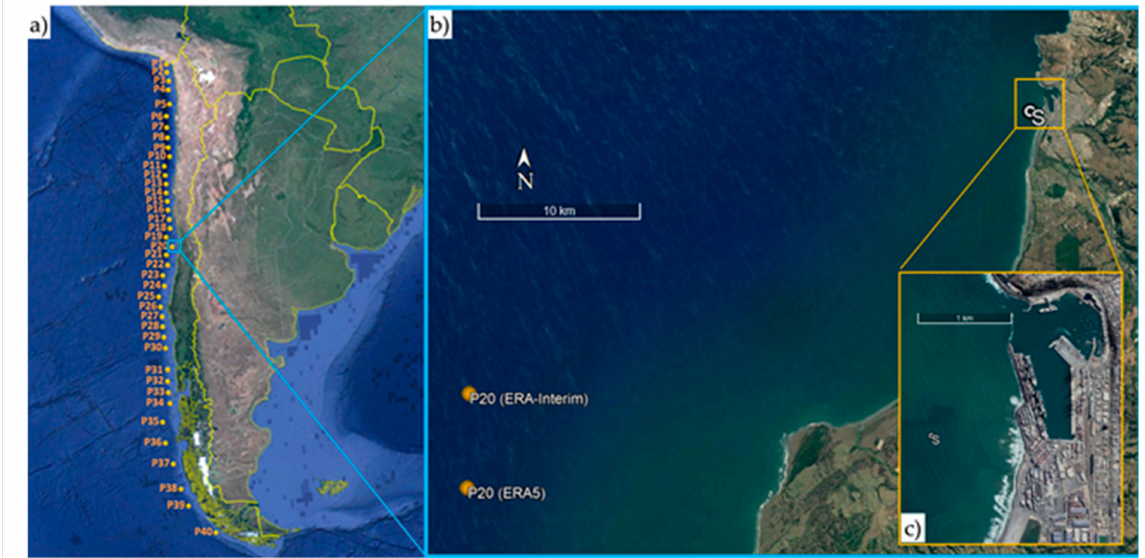
Figure 1. ( a ) ERA—Interim grid points (P1-P40) along the Chilean coast. ( b ) Map of the nearshore area with indication of the position of the point P20 (P20 from ERA5 dataset and nearshore point S are also depicted). ( c ) Detailed view of the study site showing location of the analyzed installation at San Antonio